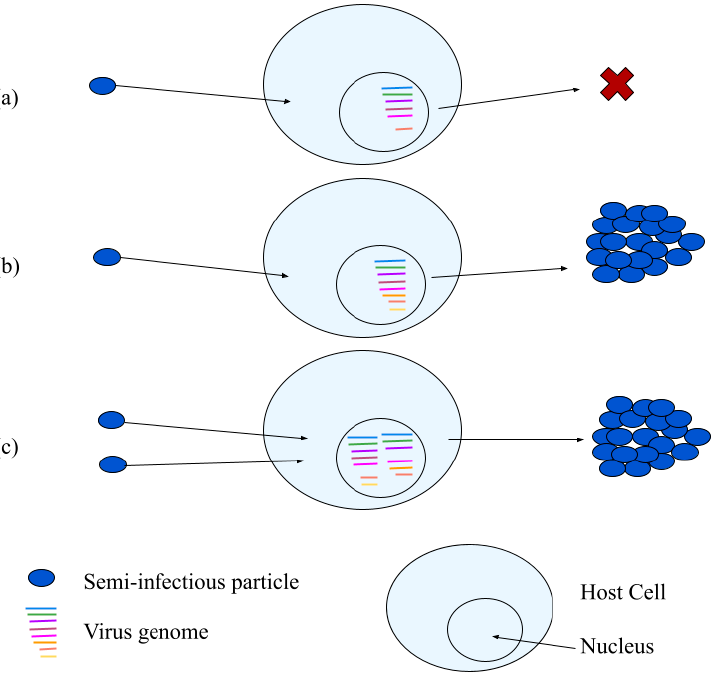
Figure 5. Three potential fates of semi-infectious particles. ( a ) A particle infects its host cell but at least one essential gene fails to be expressed, so the cell makes no progeny, ( b ) a particle infects its host cell, all essential genes are expressed; the cell make progeny, and ( c ) two or more particles co-infect a host cell, gene or functional deficiencies are overcome by complementation, and the cell makes virus progeny.